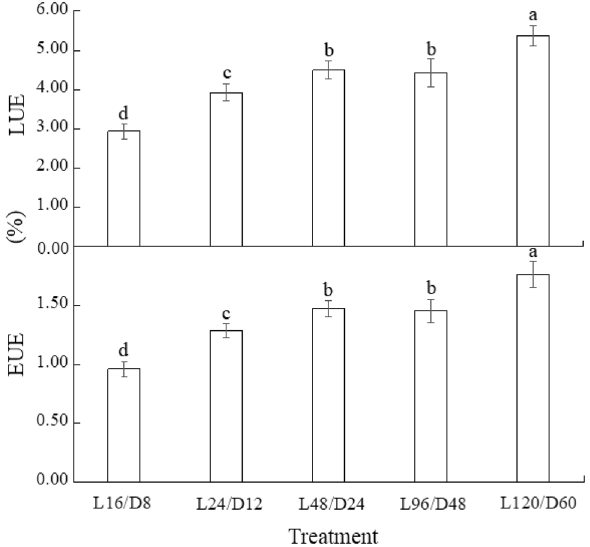
Figure 4. The LUE and EUE of lettuce exposed to different L/D cycle treatments of RB. Different letters for the same parameter indicate significant differences at the 5% level, according to the Tukey’s test (n = 3). The bars represent the standard errors. LUE—the light use efficiency; EUE—the electric use efficiency. L/D—light/dark. L16/D8—16 h light/8 h dark (as control), L24/D12—24 h light/12 h dark, L48/D24—48 h light/24 h dark, L96/